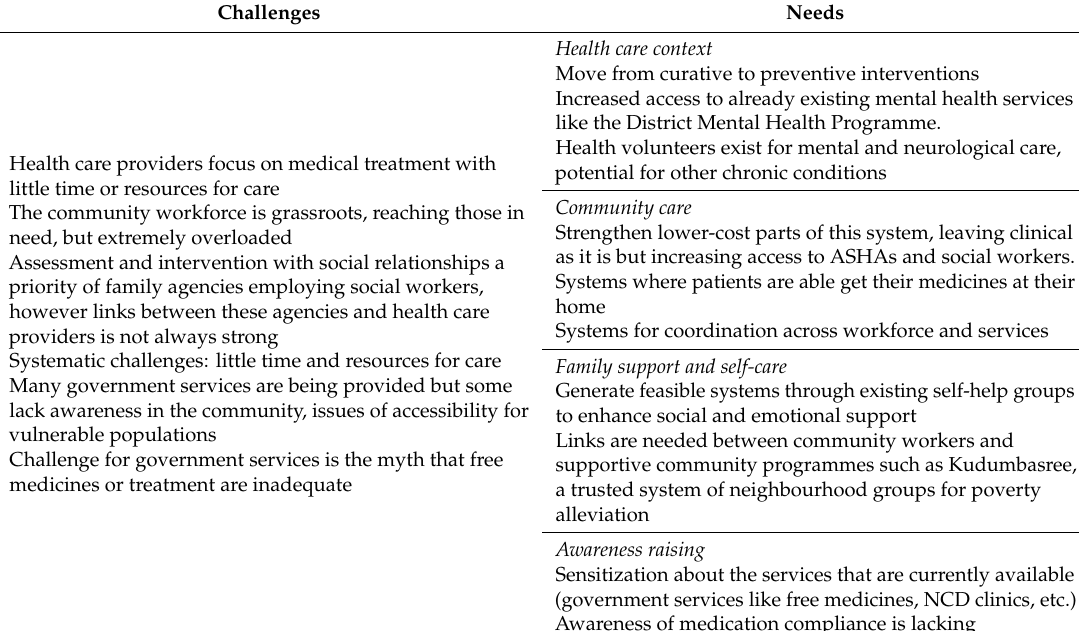
Table 2. Stakeholder workshop